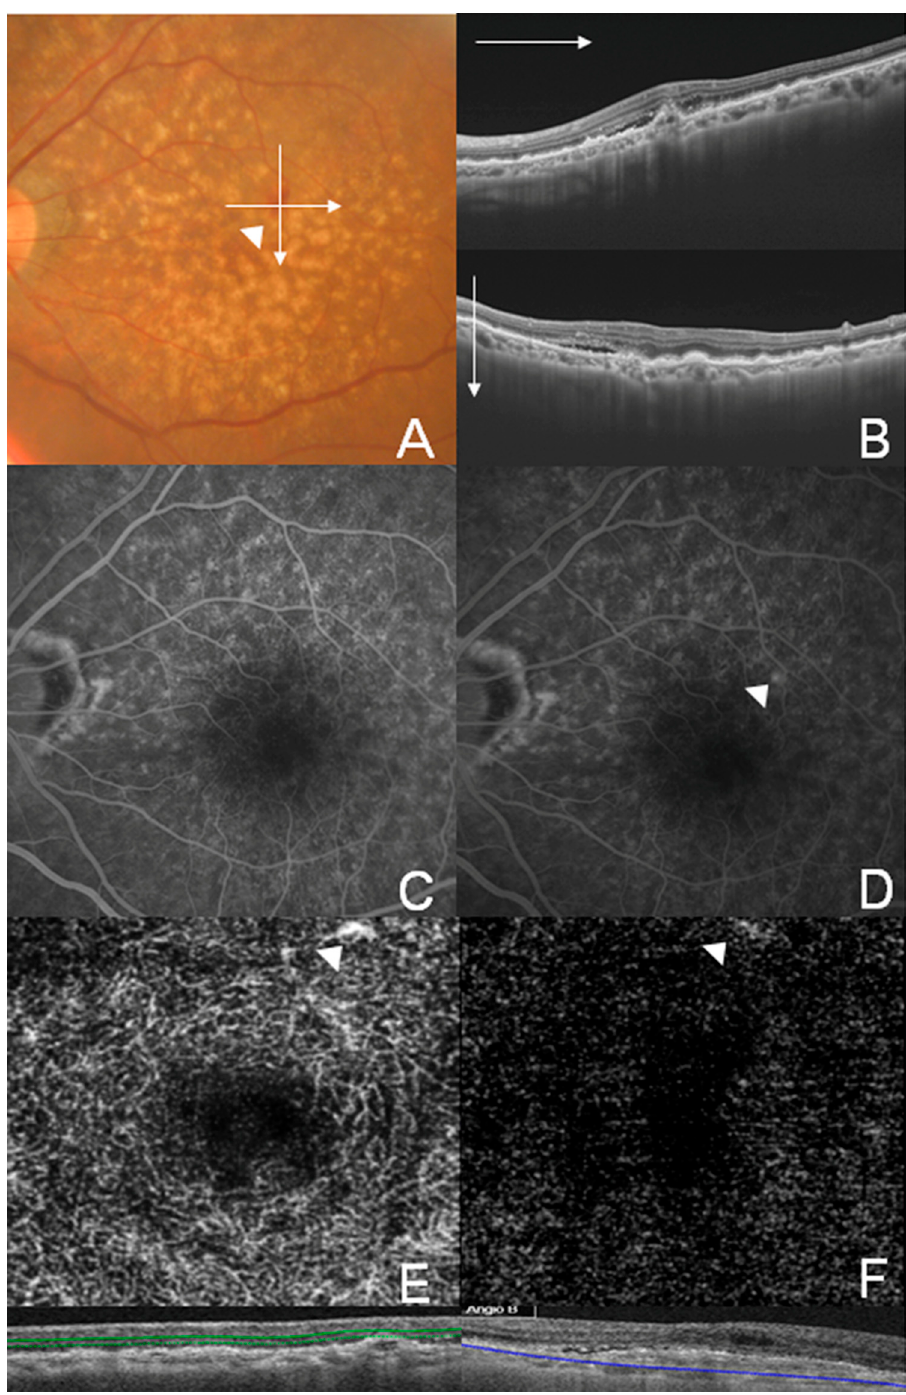
Figure 5. Multimodal imaging of the left eye of a 63-year-old female showing type 3 choroidal neovascularization (CNV). ( A ) Color fundus photograph showing multiple drusen and intraretinal hemorrhage associated with CNV; ( B ) Swept-source optical coherence tomography (OCT) image through the white line drawn on color photograph showing drusenoid retinal pigment epithelium detachment; ( C , D ) Early ( C ) and late ( D ) phase of the fluorescein angiography (FA). Type 3 CNV is not clearly identifiable with FA; ( E , F ) OCT angiography images showing intraretinal vascular tuft of the deep retinal capillary plexus layer ( E ) and outer retina layer ( F ). The white arrowhead indicates a small but distinct type 3 CNV lesion.